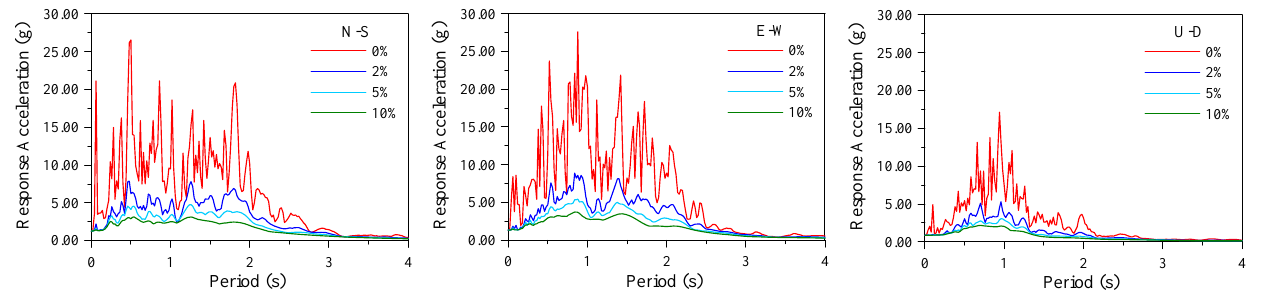
Fig. 6 Response spectrums of Bala (Ankara) Earthquake on December 20, 2007.